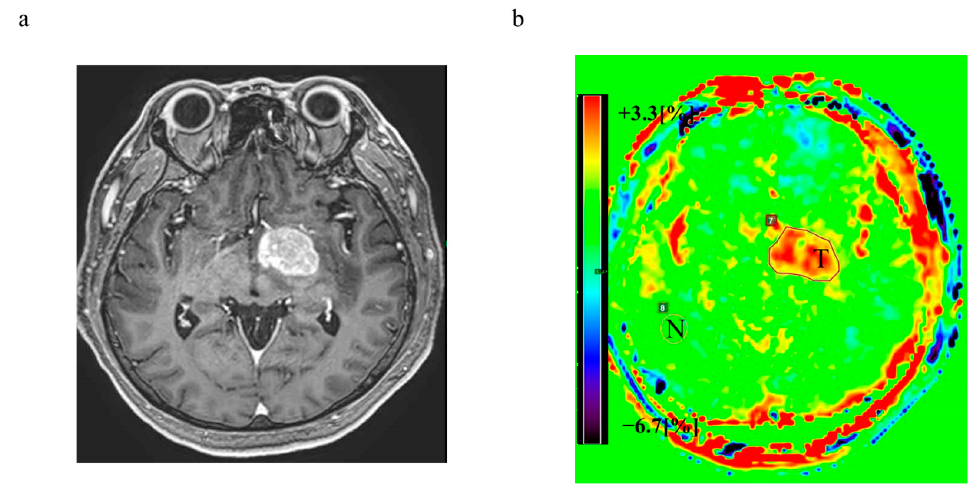
Figure 1. Representative ( a ) T1-weighted image with gadolinium and ( b ) ATPw image. T: tumor, N: normal tissue; ATPw image: amide proton transfer-weighted image.